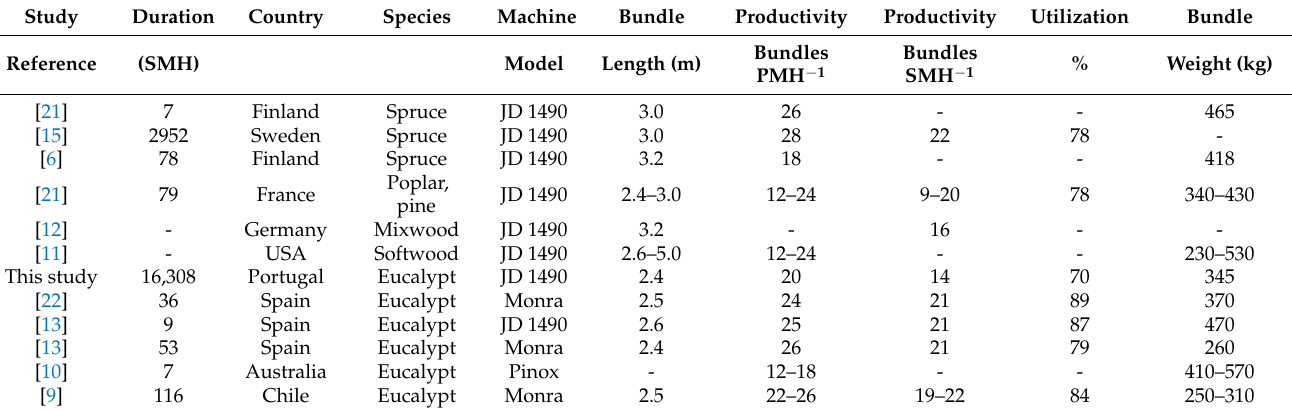
Table 7. Comparison with the results of previous studies of forwarder-mounted